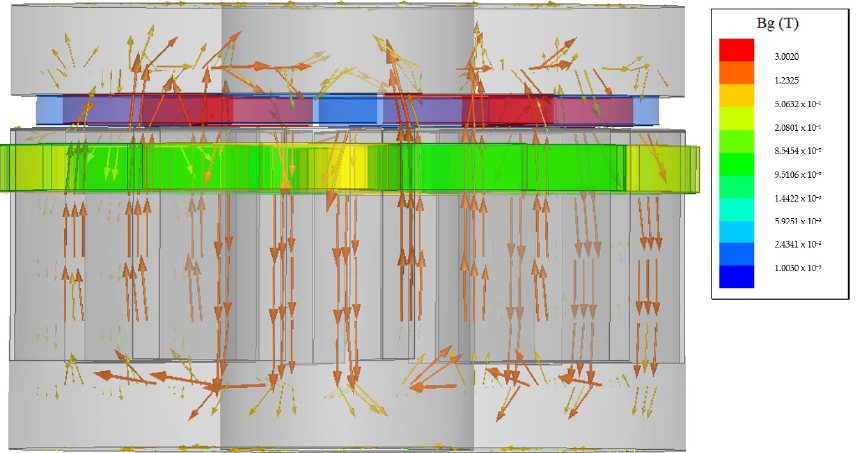
Figure 10. Magnetic flux density vector path of M 2 with configuration 10.